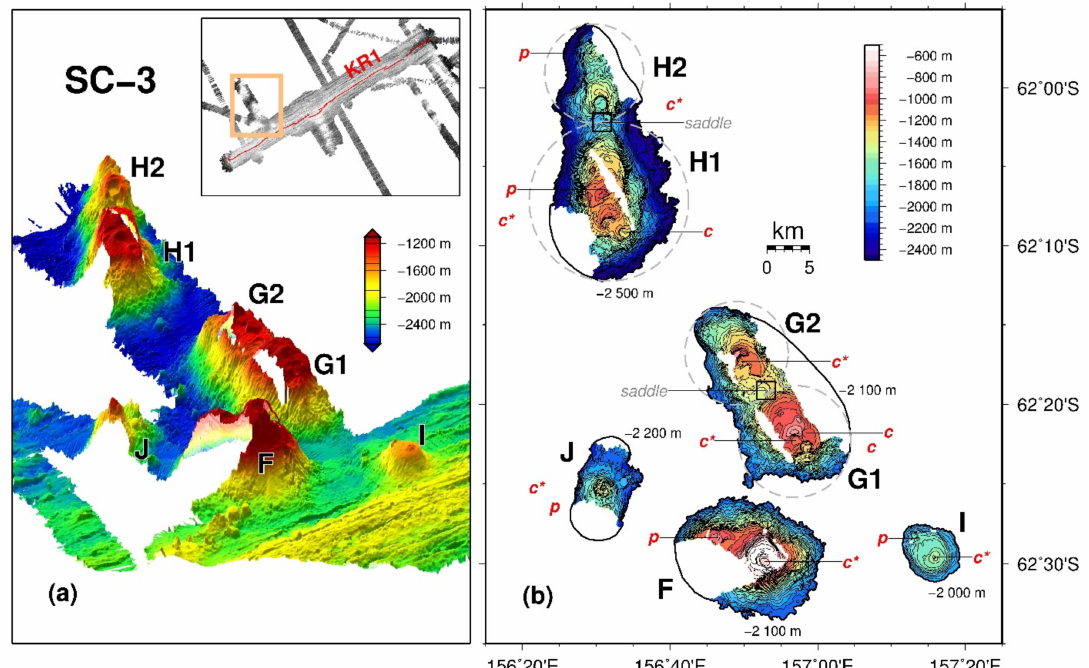
Figure 4. ( a ) A 3-D perspective plot with 5x vertical exaggeration for seamount chain SC-3; ( b ) detailed geomorphologies of seamounts F, G (=G1 + G2), H (=H1 + H2), I, and J from each reference depth (i.e., 2000 m for seamount F; 2100 m for G and I; 2200 m for J; 2500 m for H) with 50 m contour are represented along with the summit types of the seamounts (c = crater/caldera; p = peak; f = flat top). The letters with asterisks indicate the representative summit for each